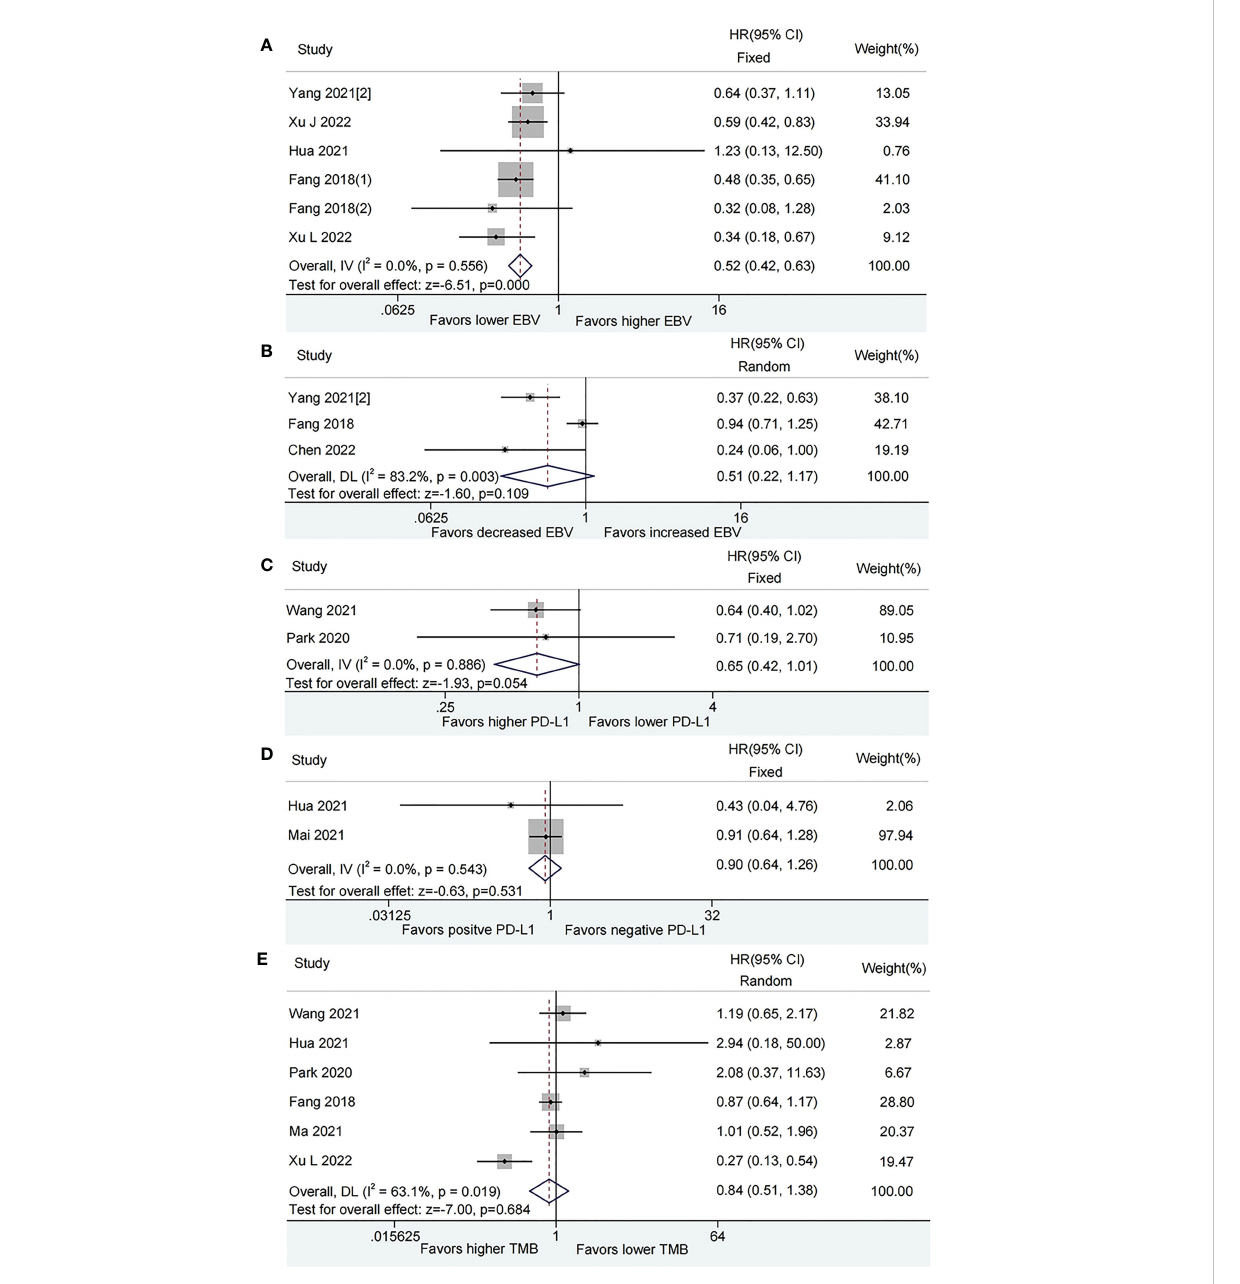
FIGURE 3 Meta-analysis of the association between biomarkers and progression-free survival (PFS). (A) baseline plasma Epstein-Barr virus (EBV) DNA level and PFS; (B) Dynamic plasma EBV DNA load during immunotherapy and PFS; (C) programmed cell death-ligand 1 (PD-L1) expression [higher vs. lower] and PFS; (D) PD-L1 expression [positive vs. negative] and PFS; (E) tumor mutation burden (TMB) and